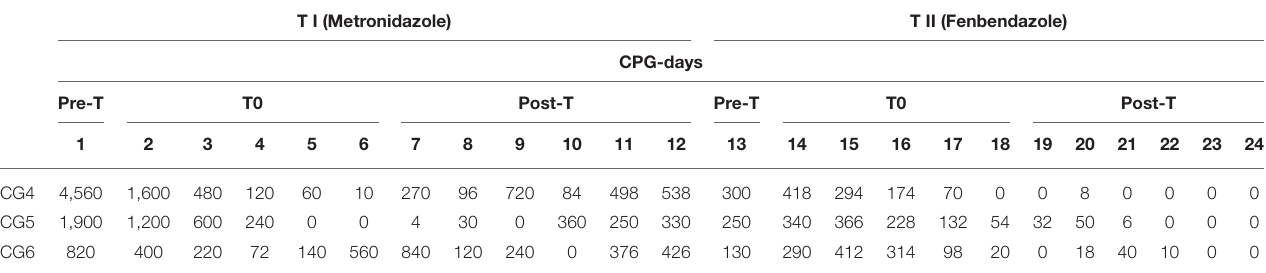
TABLE 3 | Results of Giardia cyst per gram (CPG) for all the animals in each cage (CG4, CG5, and CG6) during the entire study (pre-treatment and post-treatments T1 and T2) for Group M. T I